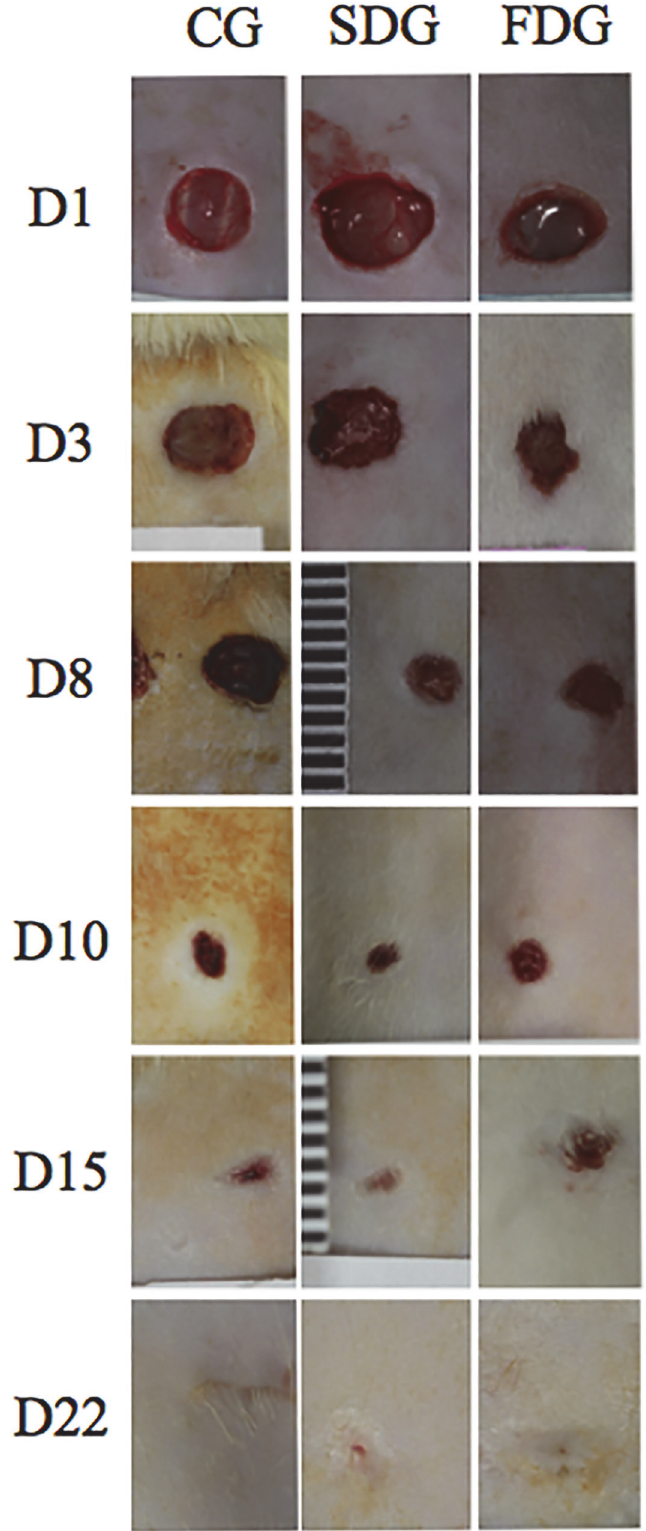
Fig 1. Wound healing in different groups throughout experiment (D = Day, CG = Control Group, SDG = Single Dose Group, FDG = Fractionated Dose Group). Original magnification 10x) doi:10.1371/journal.pone.0122042.g001 PLOS ONE | DOI:10.1371/journal.pone.0122042 April 24,